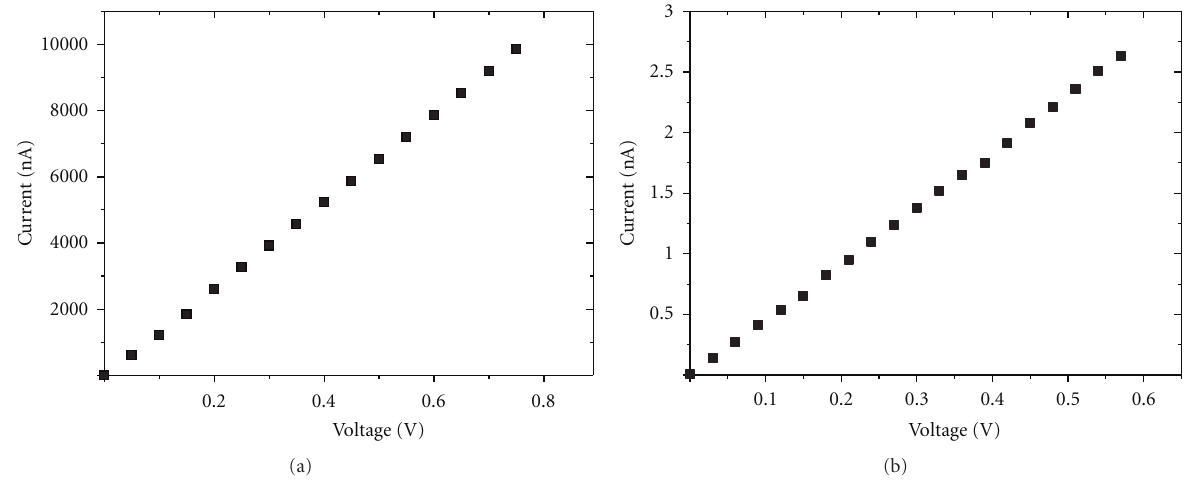
Figure 7: I - V characteristics (a) before anodization and (b) after anodization. The resistance increases from 0.076 M Ω to 217M Ω .